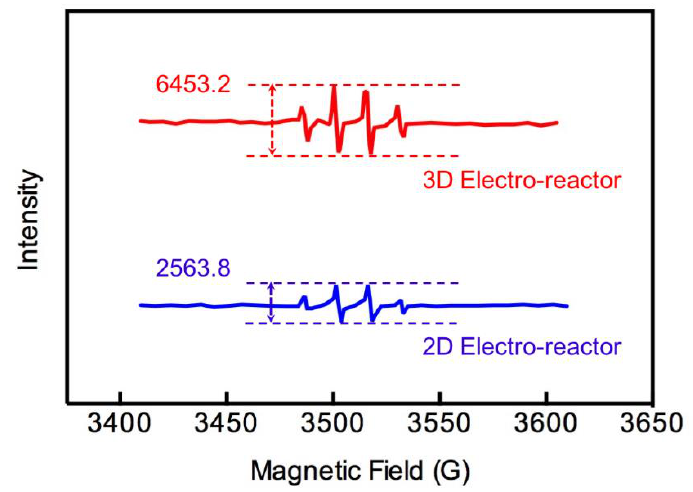
Figure 4. Dimenthyl,1-pyrroline-N-oxide (DMPO) spin trapping the electron paramagnetic resonance (EPR) spectra of hydroxyl radicals (OH) in the 3D and 2D electro-reactors.